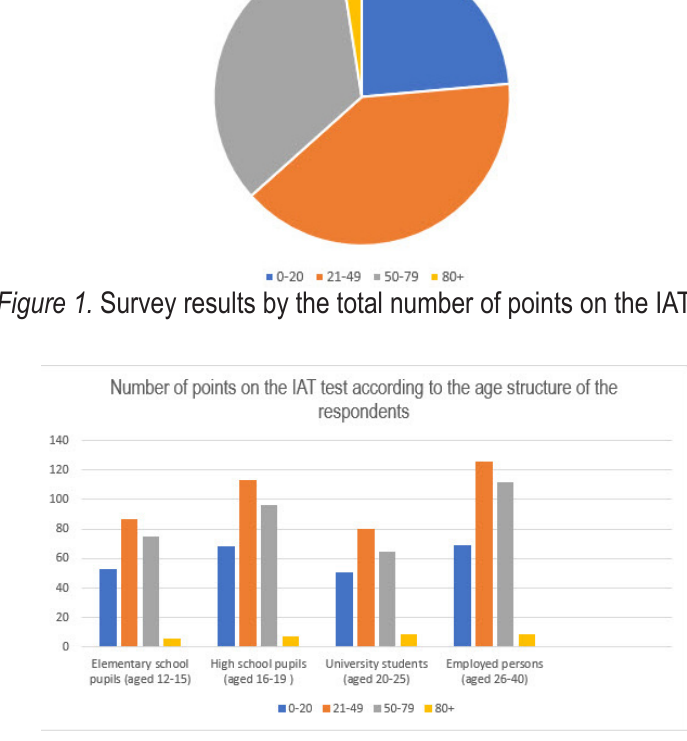
Figure 2. The results of the research presented according to the age structure of the